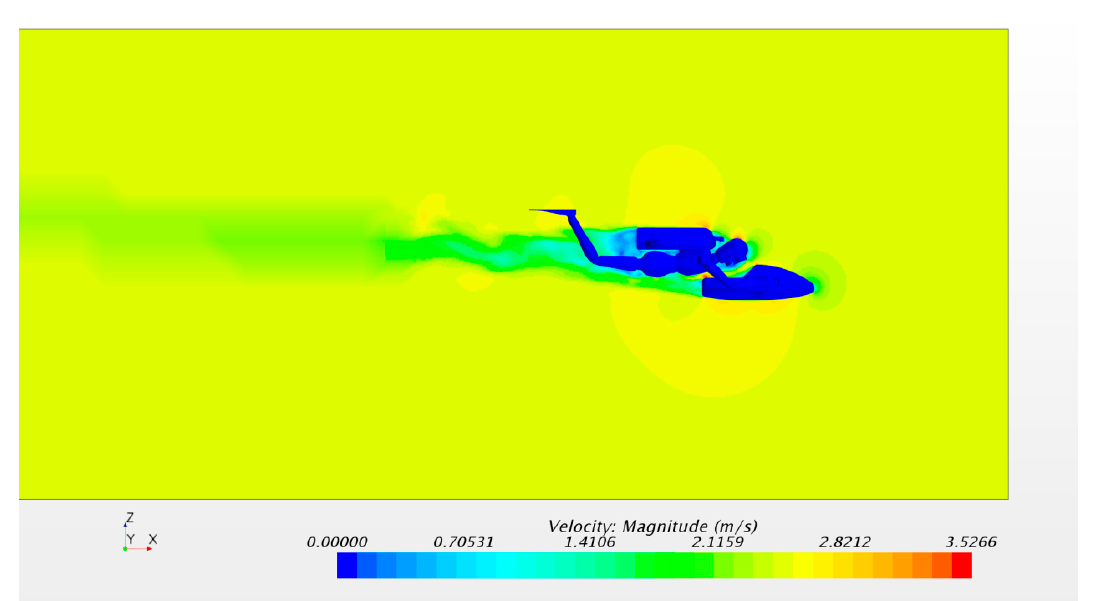
Figure 13. Velocity nephogram at 3s moment of constrained straight-line cruising simulation. Then the straight-line thrust F t required by V 5 =2.5 m/s is obtained. Because of the resistance tends to converge after 1s, the resistance value in the period of 1–3 s is taken as the arithmetic average. That is, F f = F t = 300.4 N, z -axis lift F l = − 14.2 N. Next, the resistance prediction of constrained straight-line cruising under V 5 = 2.5 m/s is selected for grid independent. According to ITTC (International Towing Tank Confer- ence) [25], the grid side length is set as 1/2000–5/2000 of the model length L , which is 1 cm in this paper. There set three different length as 1 cm, √2 cm, and 2 cm to generate coarse mesh. The total number of meshes is 7659620, 2708494, and 957453. When the other parameters and settings are the same, the change trend of resistance value with the foundation size is observed as Figure 14.